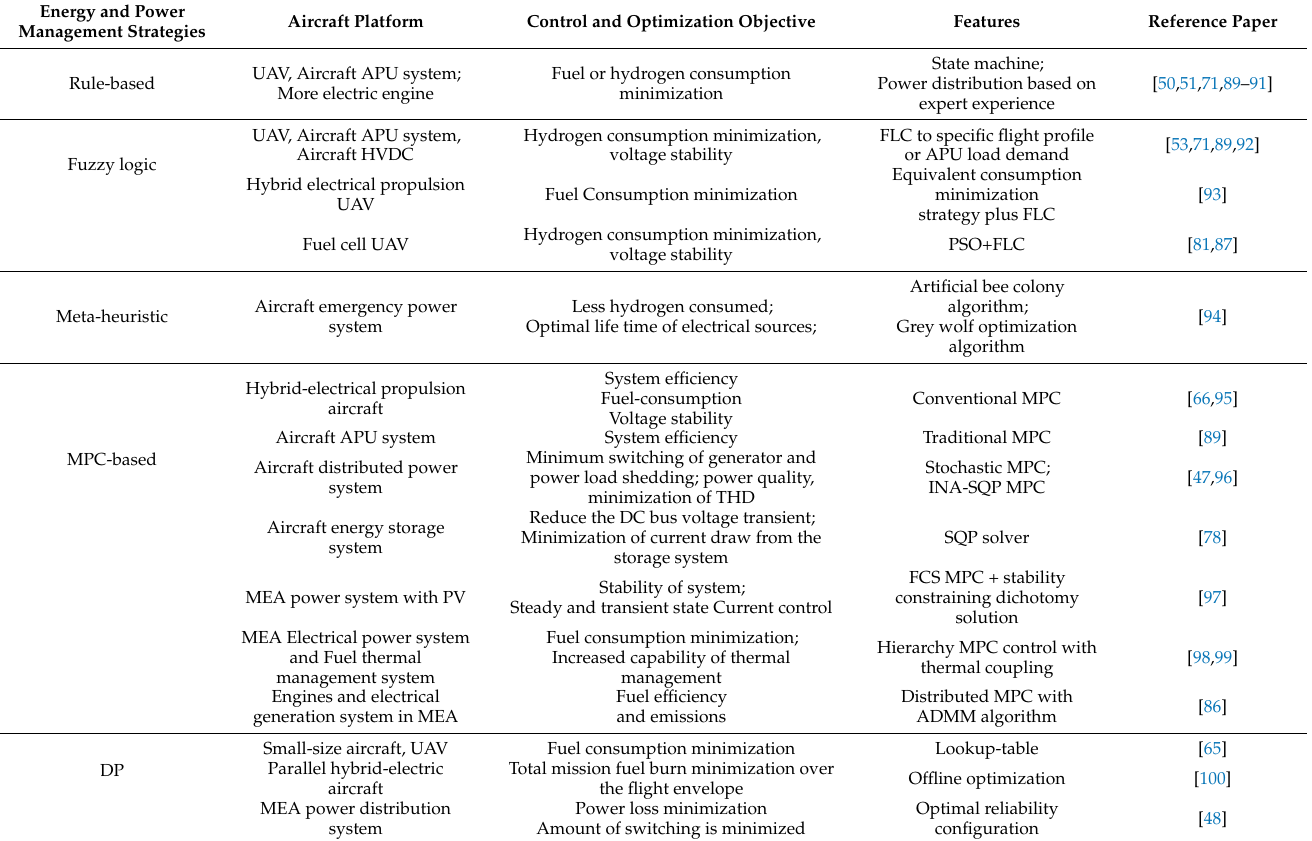
Table 2. The summarized energy and power management methods for different aircraft